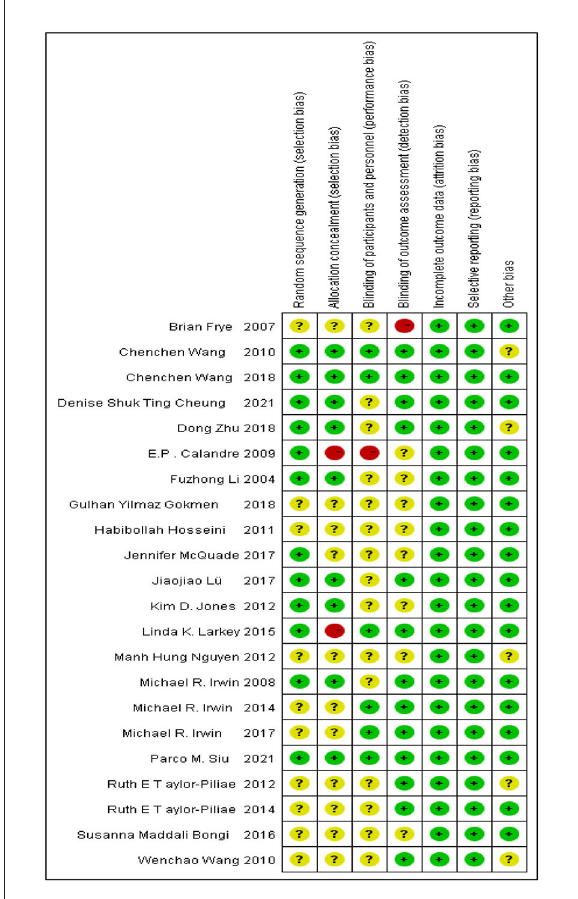
FIGURE2 Risk of bias summary: review authors’ judgments about each risk of bias item for each included study.